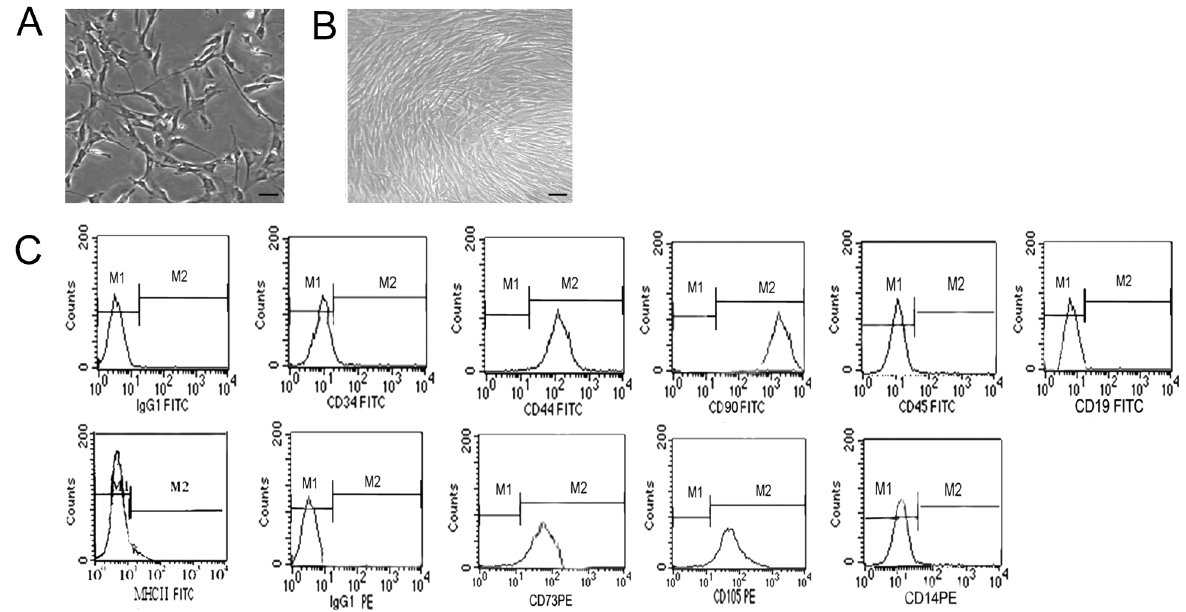
Figure 1. Characterization of hUC-MSCs. A , hUC-MSCs at passage 1 displayed a spindle-shaped or polygonal morphology in monolayer culture. B , hUC-MSCs at passage 5 became a predominant fibroblast-like morphology and formed a squamous eddy-like structure. Bar = 50 m m. C , Flow cytometric analysis of surface antigen markers. hUC-MSCs expressed CD44, CD105, CD73, and CD90, but not CD34, CD45, CD19, CD14, or MHC II. PE- and FITC-conjugated mouse monoclonal IgG1 were used as isotype